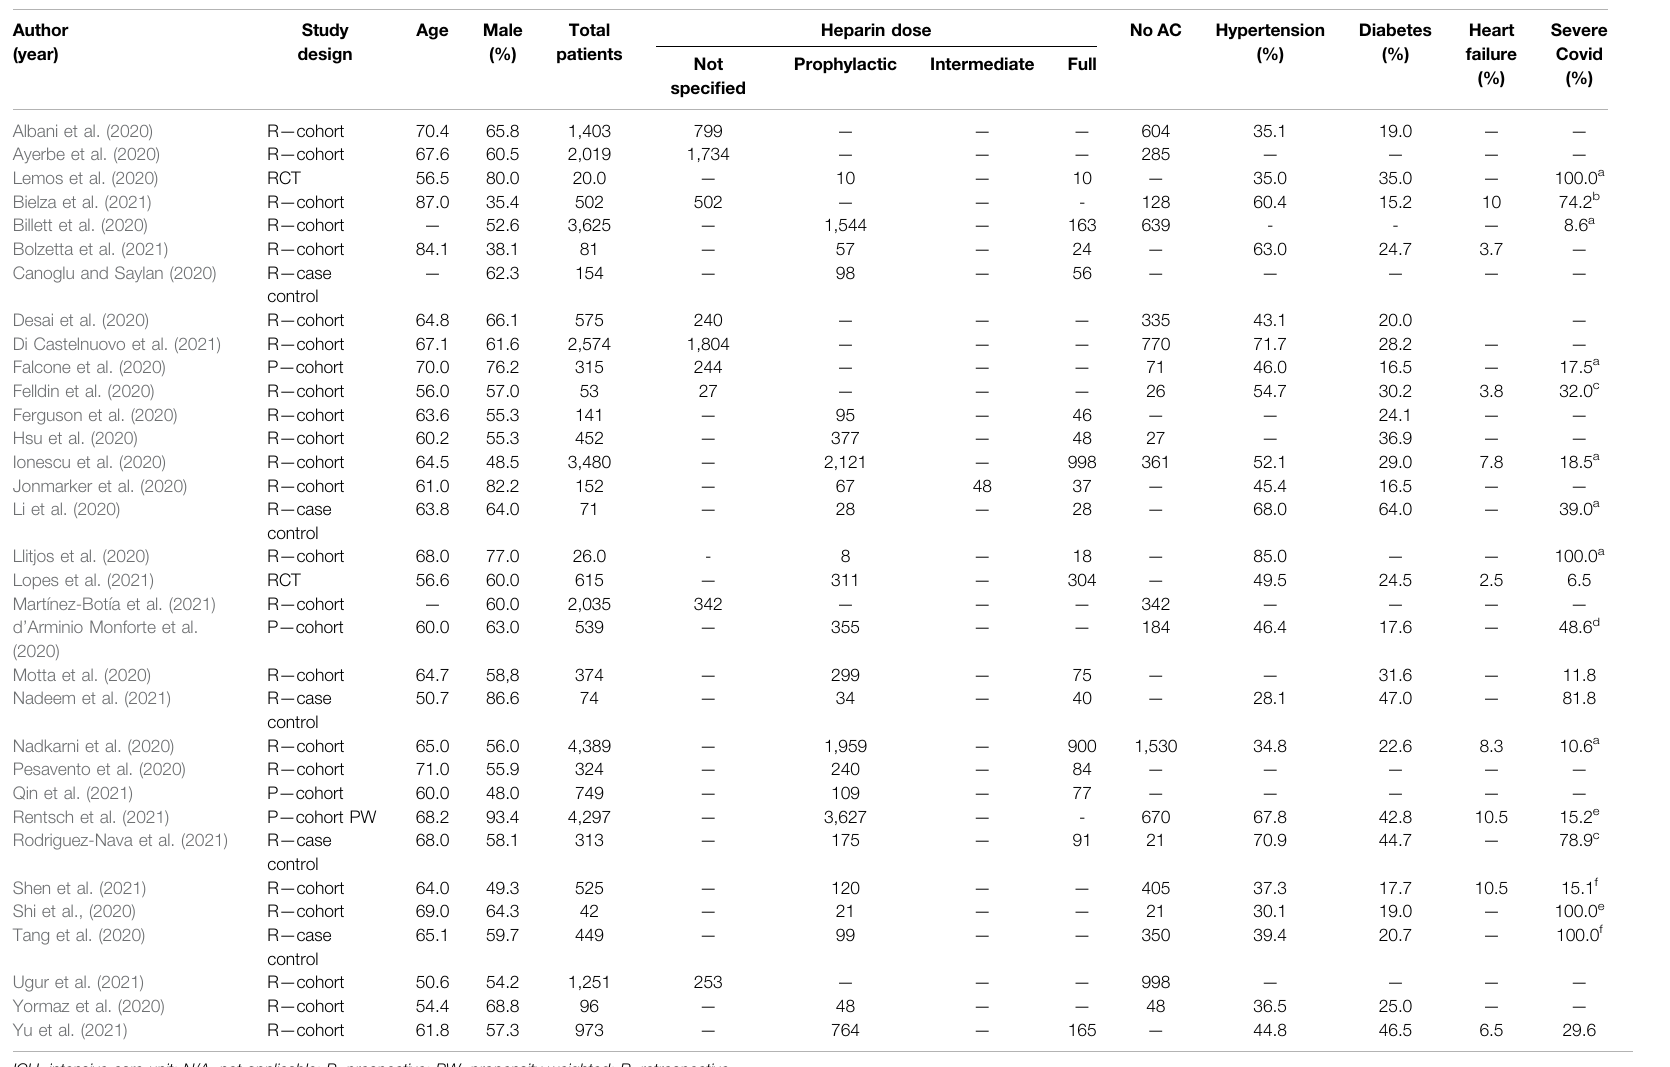
TABLE 1 | Clinical characteristics of studies included in the